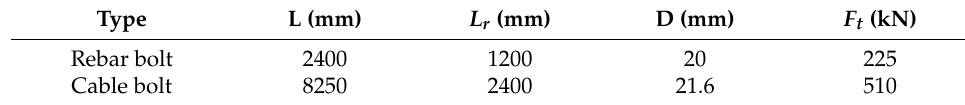
Table 2. Mechanical parameters of the retaining